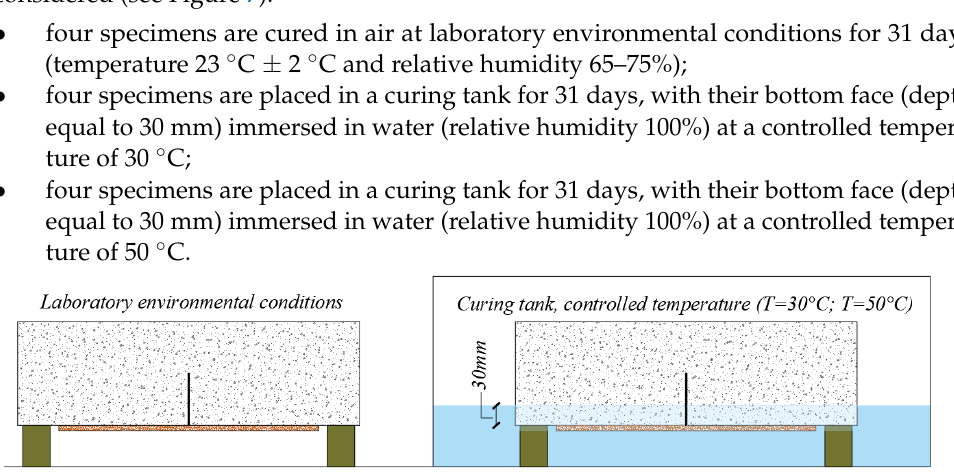
Figure 8. Experimental DIC test setup.